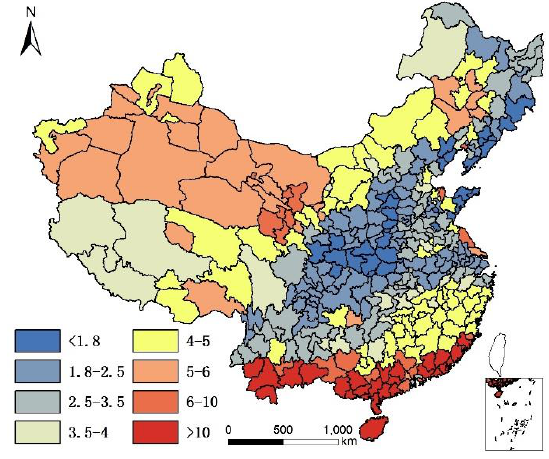
Figure 8. Water-soluble selenium content in soil of each city in China (ug/kg).